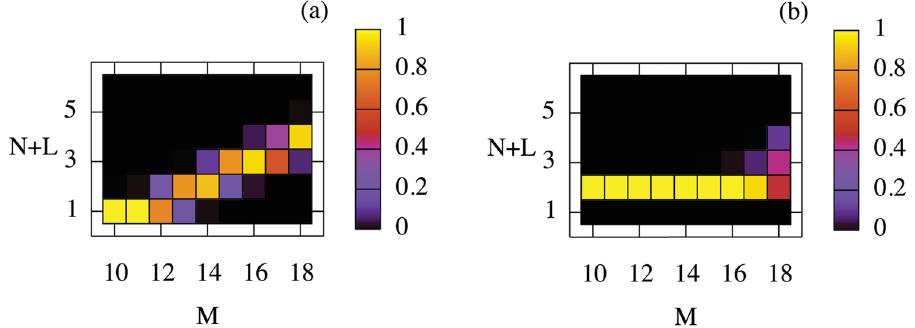
Figure 4. Equilibrium probabilities of observing different M , N + L variants at given values of the helium content M at T = 1000 K . Probabilities are normalized so that ∑ =